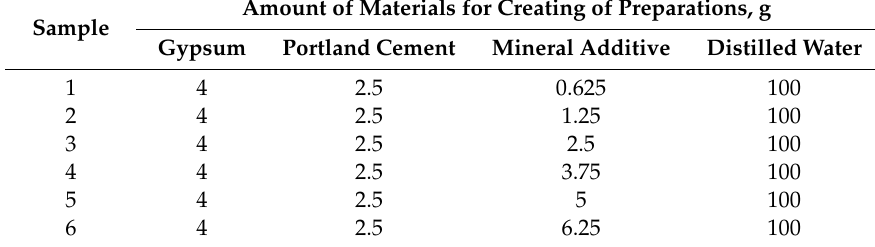
Table 5. Compositions of preparations for determining the e ff ect of mineral additives on the concentration of CaO in aqueous gypsum-cement suspensions. Amount of Materials for Creating of Preparations, g Sample Gypsum Portland Cement Mineral Additive Distilled Water 1 4 2.5 0.625 100 4